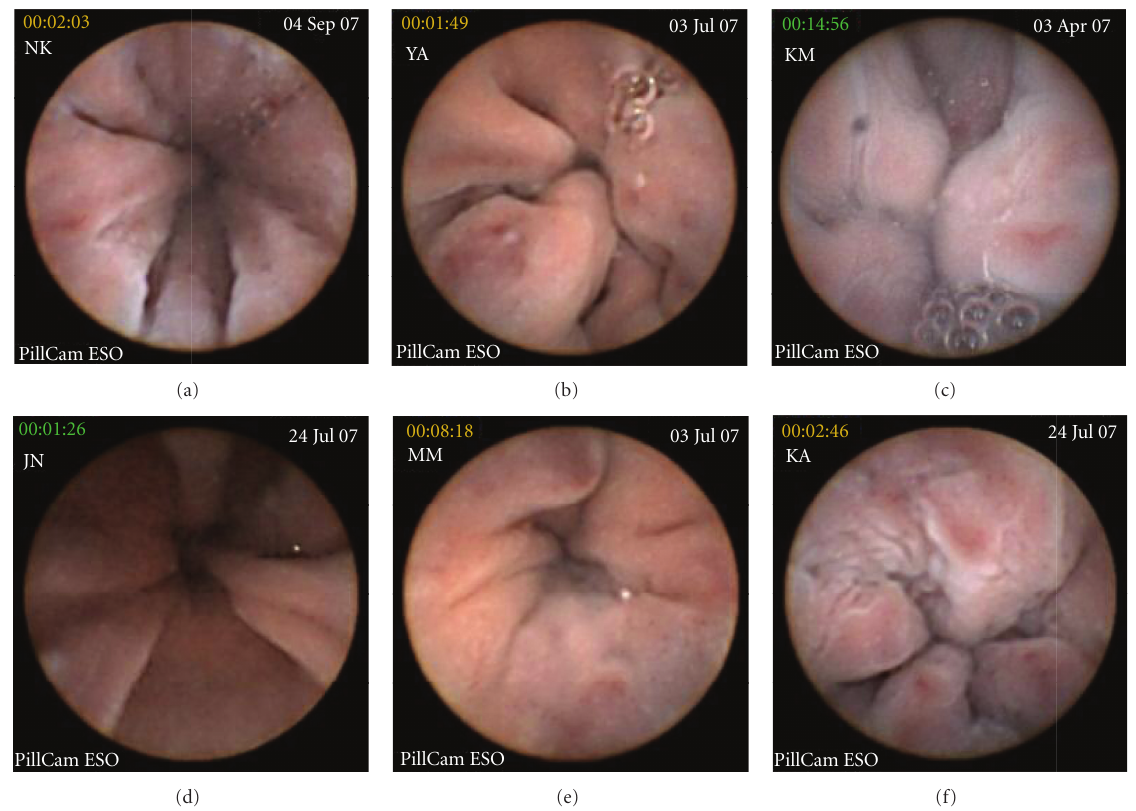
Figure 1: Images acquired using esophageal capsule endoscopy show (a–c) form (F) and (d–f) red (RC) signs of esophagogastric varices (EVs). Examples of EVs classified as F1 (a), F2 (b), and F3 (c), as well as RC0 (d), RC1 (e), and RC2 (f).